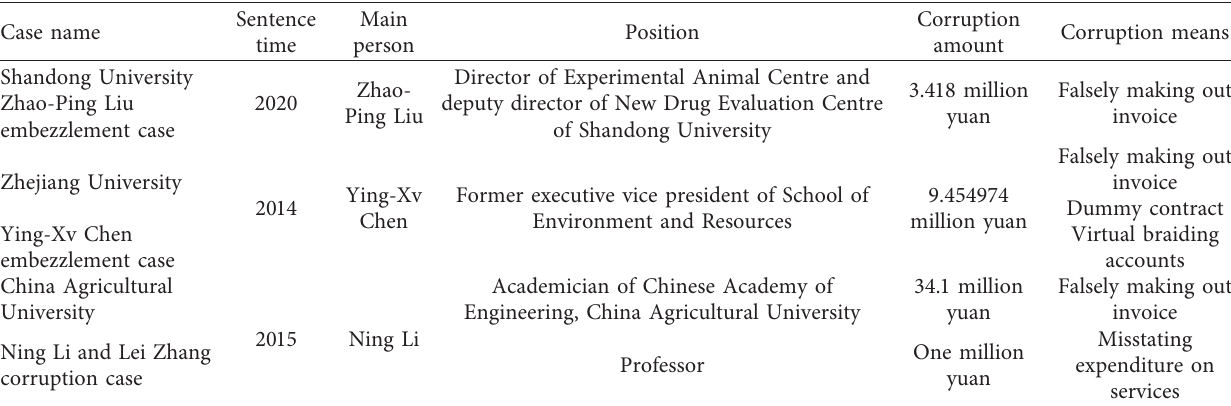
Table 1: Basic information of the